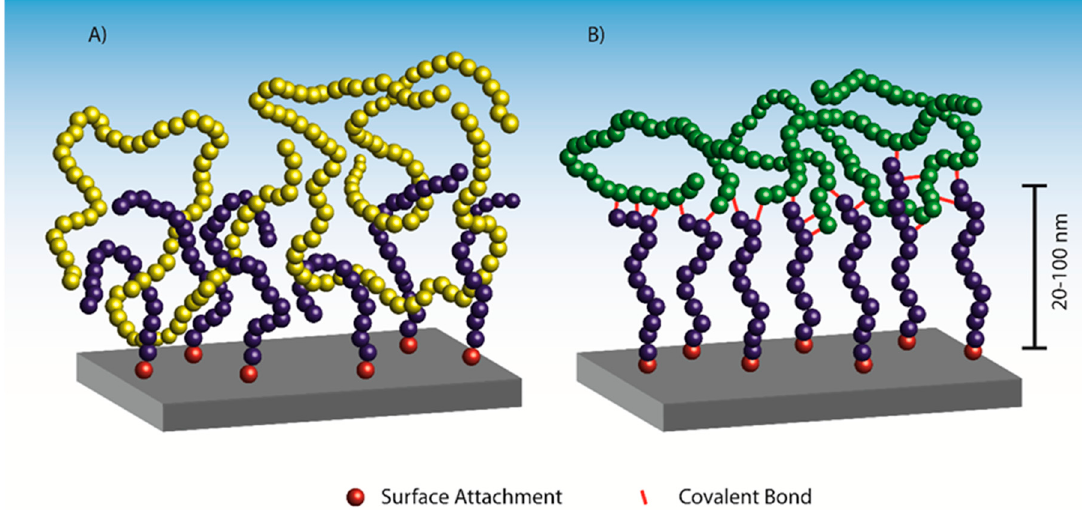
Figure 1. Sketch of polymer brush-based adhesion via ( A ) the entanglement and physical interactions and ( B ) the covalent bonds between the polymer brushes and a bulk polymer matrix.